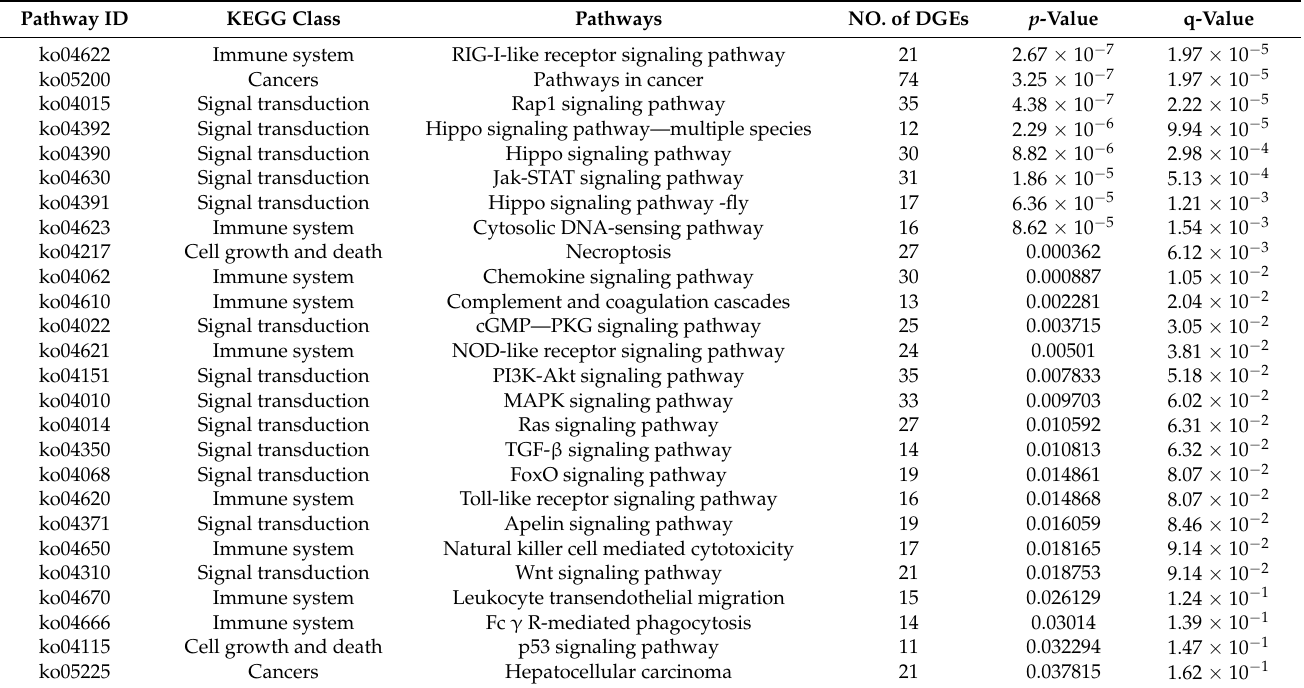
Table 2. 26 important pathways related to NK cell